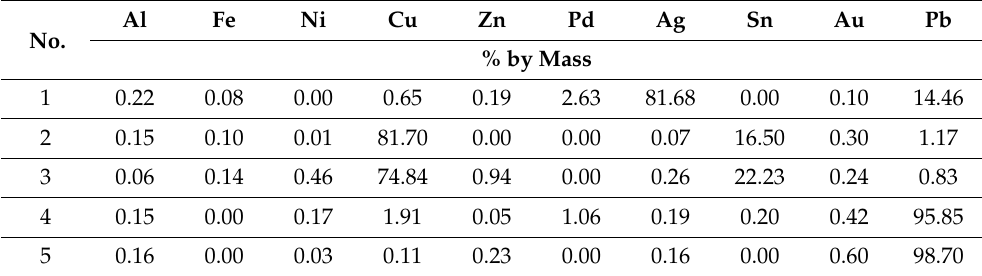
Table 12. Point chemical compositions of the lead ingots after melting with PCB pyrolyzate